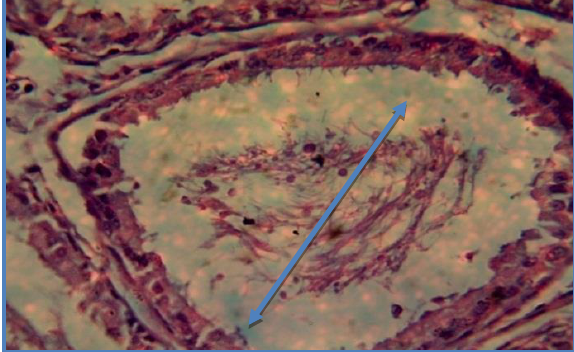
Figure, 6: Cross section of rat epididymis of group T1 showing few sperms in the lumen with round dark nuclei cells (H and E stain 40x).